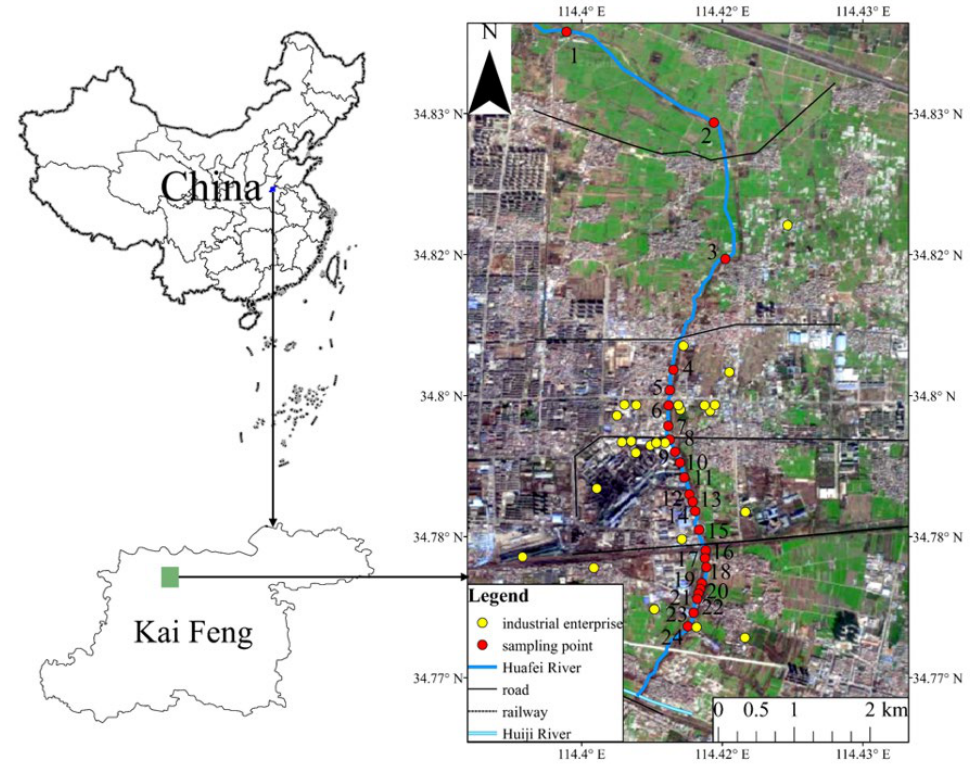
Figure 1. Sampling location map of the study area.